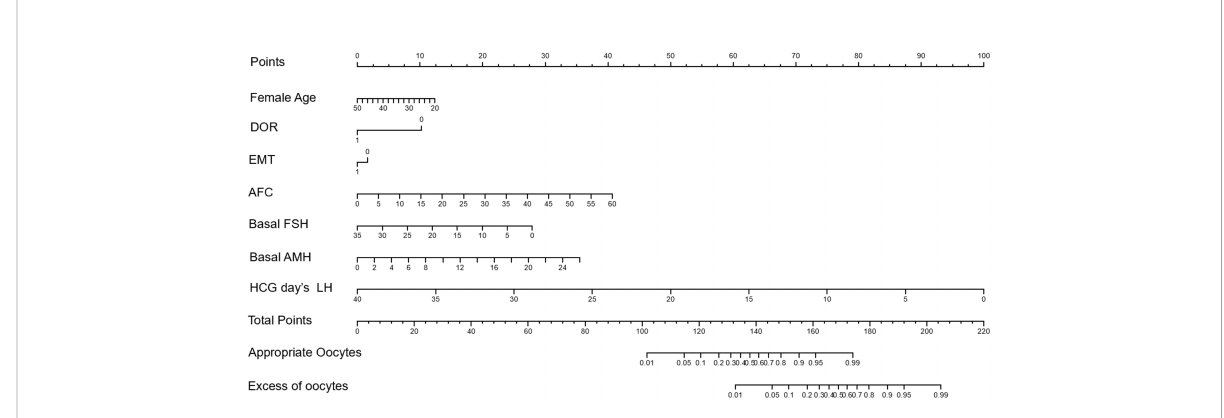
FIGURE 1 Nomogram model for the prediction of optimal ovarian response and hyperresponsiveness in patients treated with GnRH antagonist